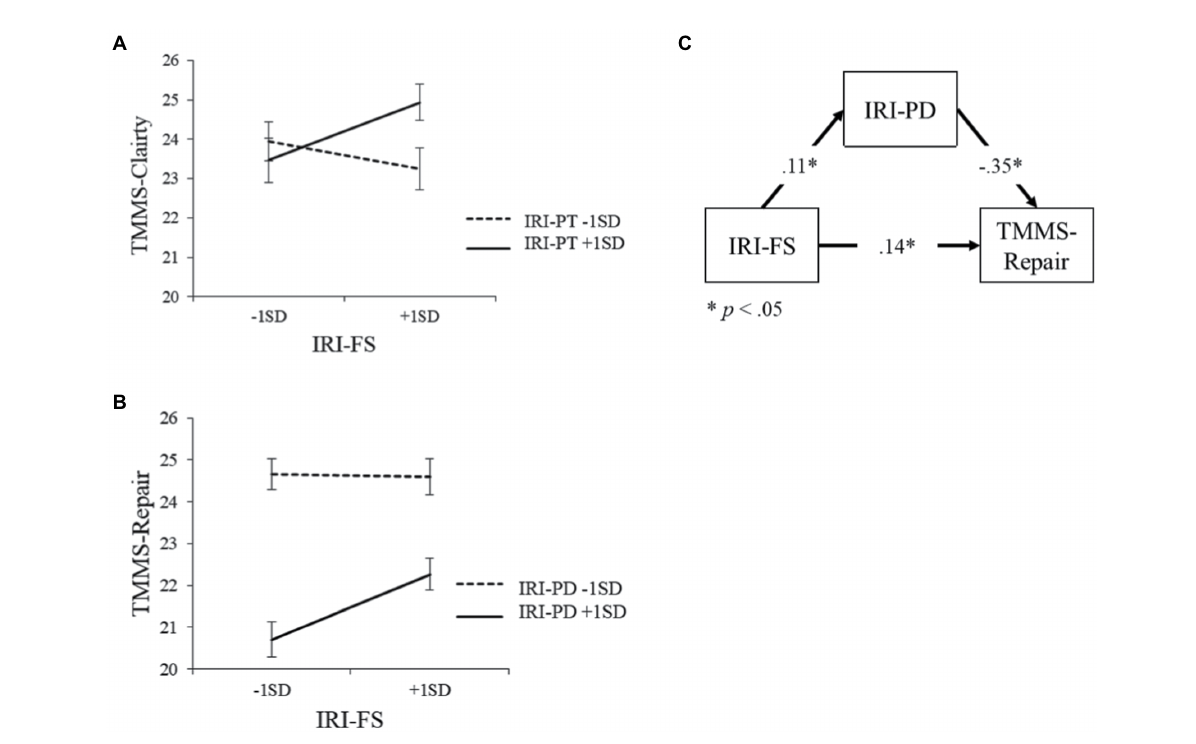
FIGURE 1 The relationship between fantasy, perspective-taking, personal distress, metacognitive clarity, and metacognitive repair. (A) Moderating effect of perspective-taking on the relationship between fantasy in the IRI-J and clarity in the TMMS-J. (B) Moderating effect of personal distress on the relationship between fantasy in the IRI-J and repair in the TMMS-J. (C) Mediation model of fantasy in the IRI-J, personal distress in the IRI-J, and repair in the